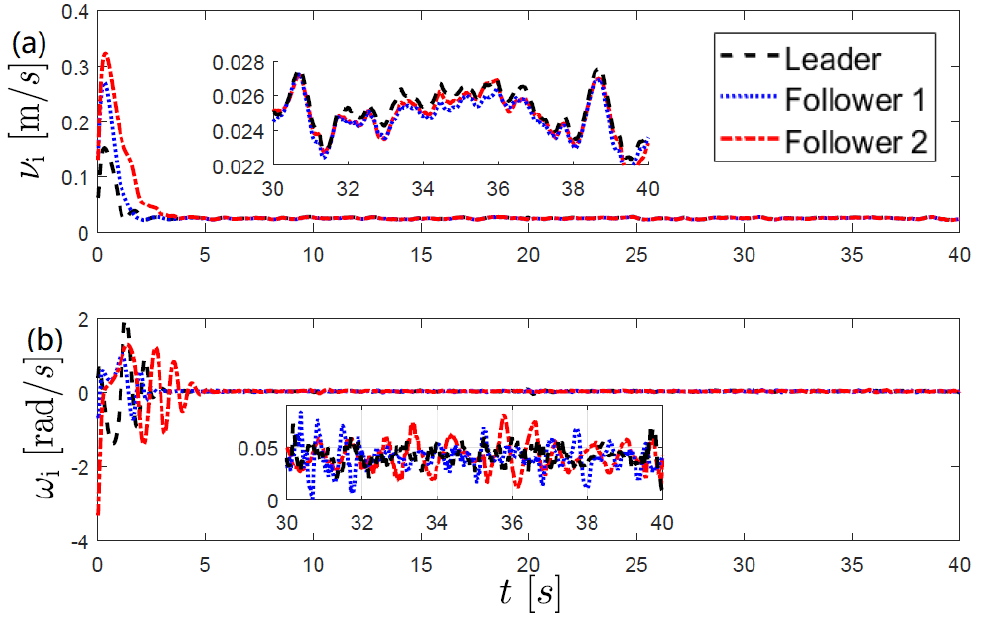
Figure 9. Control inputs obtained in the first experiment: ( a ) ν i , ( b ) ω i .